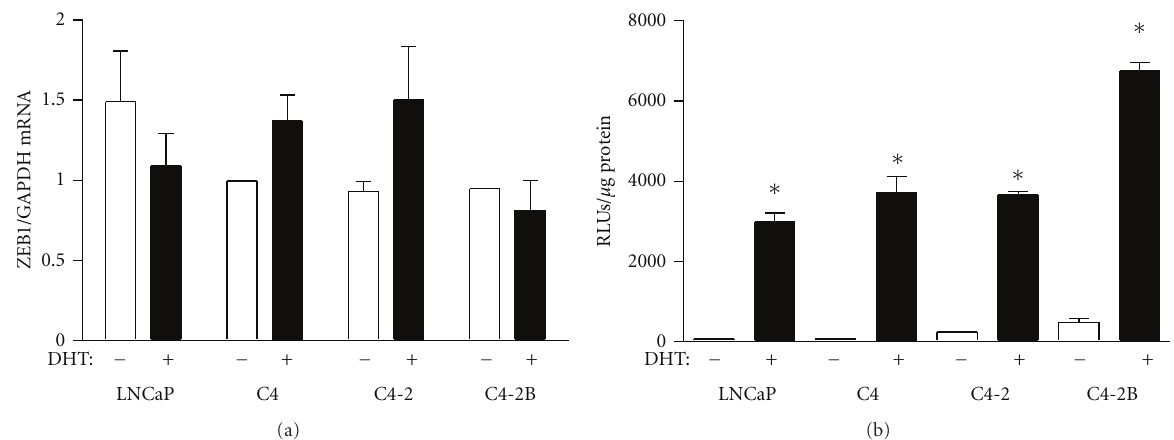
Figure 7: Endogenous tcf8 is not induced in the LNCaP cell lines . The four LNCaP-derived cell lines were each divided into two groups and were incubated with or without 5 nM DHT for 24 hrs. (a) For one group, RNA was isolated and subjected to qPCR for ZEB1 and GAPDH mRNA. ZEB1 mRNA levels were normalized to GAPDH. (b) For the second group, the cells were transfected with pBlueZEB974 at T = O, and β -galactosidase activity was determined at 24hrs. ∗ P < 0 . 0001 compared to no DHT.